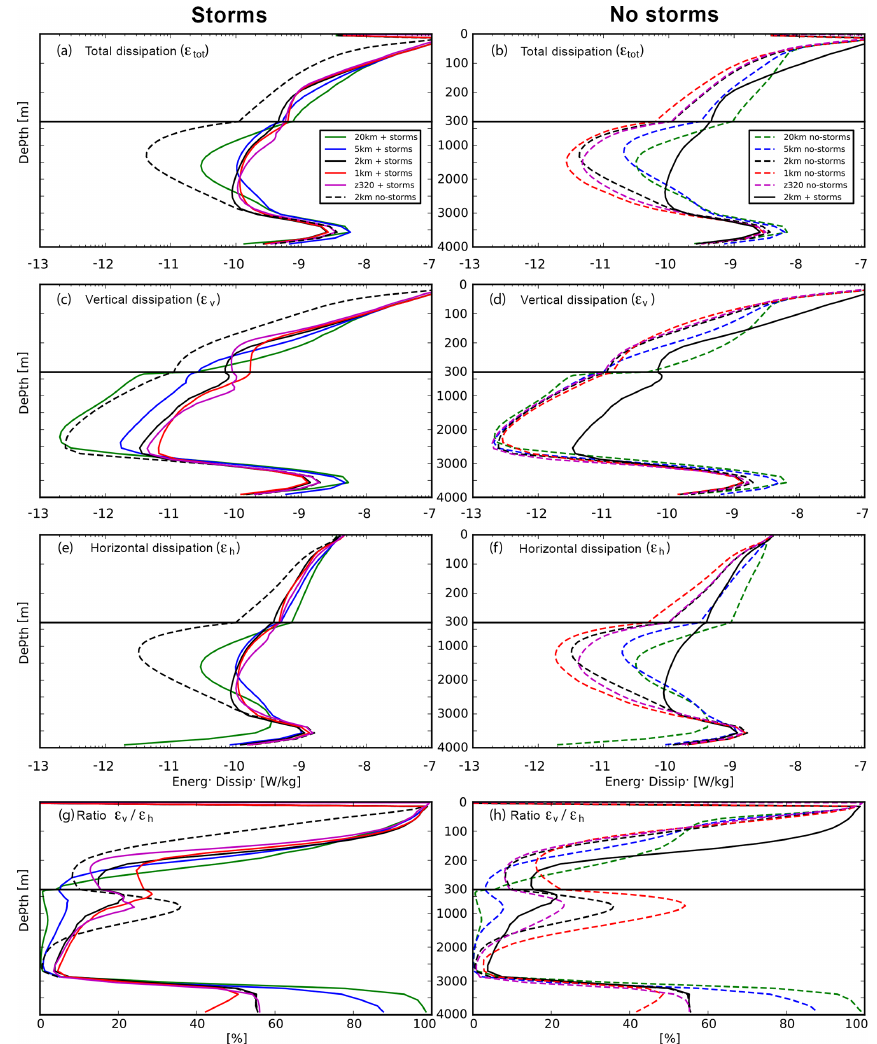
Figure 13. Kinetic energy dissipation ( ε ; Wkg − 1 ) as a function of depth in experiments at 20, 5, 2 and 1km horizontal resolution, with storms (continuous lines) and without storms (dashed lines): total energy dissipation ε with storms (a) and without storms (b) , dissipation due to vertical processes ε v with storms (c) and without storms (d) , dissipation due to horizontal processes ε h with storms (e) and without storms (f) , and the fraction of the total dissipation due to vertical processes ( ε v /ε in %) ( g and h ). As in Fig. 11, profiles are computed using 5-day snapshots of the entire domain for a 2-year period. Position, strength and duration of the storms remain strictly equal in the different experiments. The experiment z320 has an horizontal resolution of 2km but 320 vertical levels, ranging from 1m at the surface to 250m at the bottom (below 2500m depth the vertical size of the cells is the same as in the 2km reference